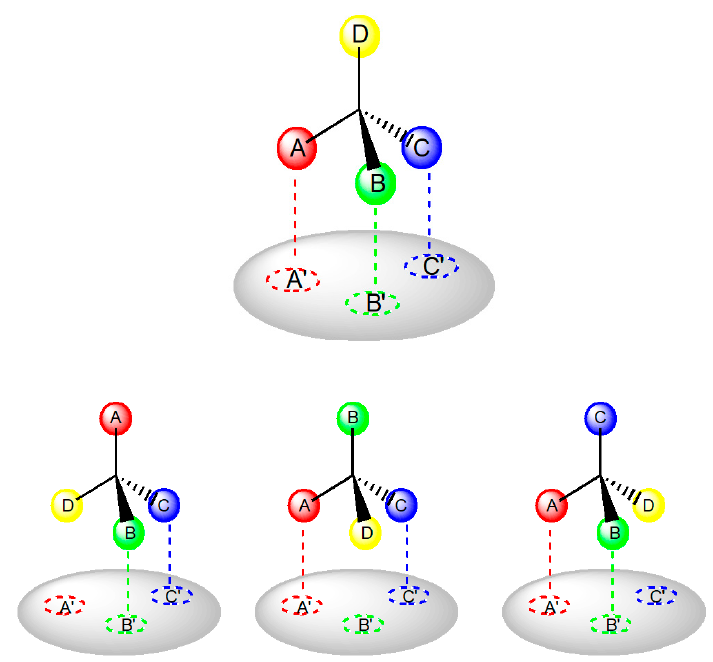
Figure 5. Interaction of a chiral drug with the receptor site [45]. The more active enantiomer is capable of achieving the correct orientation to enable all three functional groups to fit their respective binding sites on the receptor active sites A...A ′ , B....B ′ , C...C ′ . The less active enantiomers may interact at two sites only, regardless of its orientation towards the active site.